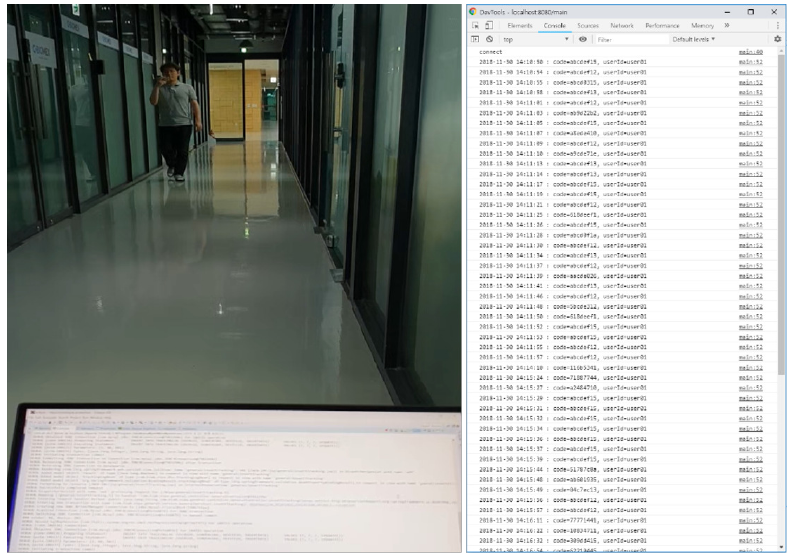
Figure 9. Ultrasound wave transmitter